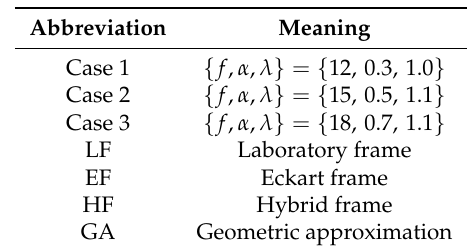
Table 1. List of shorthands and abbreviations for systems and methods used in this